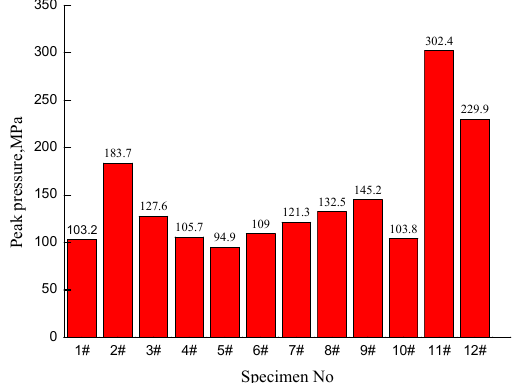
Figure 11. Distribution of peak pressure in 12 groups of core tests.